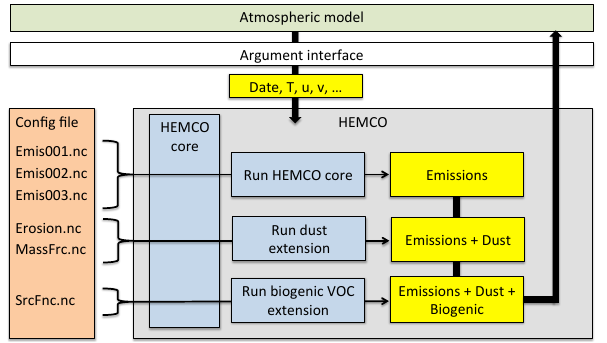
Figure 3. Use of HEMCO extensions to compute emissions with functional dependencies on local environmental variables. Three standard emission inventories (Emis001.nc–Emis003.nc) and two extensions (dust emissions and biogenic VOC emissions) are com- bined. The extensions use external gridded data (Erosion.nc, Mass- Frc.nc, SrcFnc.nc) and compute additional scale factors dependent on temperature ( T ), wind ( u,v ), etc., imported from the atmo- spheric model through the argument interface. All selected HEMCO extension are sequentially called after the HEMCO core module, and the emission arrays calculated therein are added to the emis- sions previously calculated in HEMCO core. See Sect. 2.6 for more